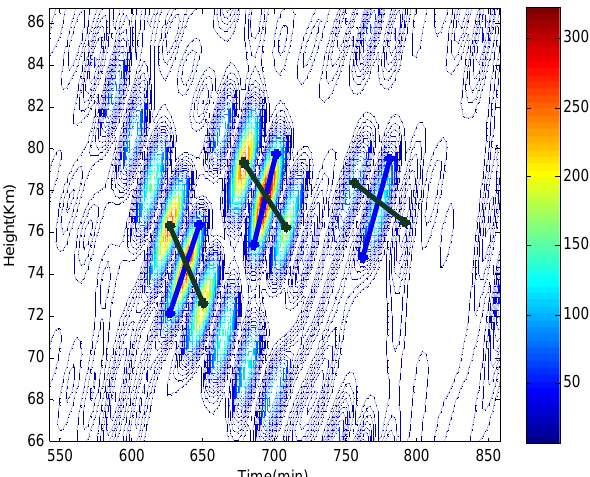
Fig. 1a. A partial height–time plot of (δV ) 2 of downward-phase propagating gravity waves converted from zonal velocity data ob- served by MU radar at Shigaraki, Japan, on 8 July 1986. Deter- mination of vertical phase and group velocities of 3 wave packets were indicated by the phase lines (along the patch) and energy lines (across the patch).